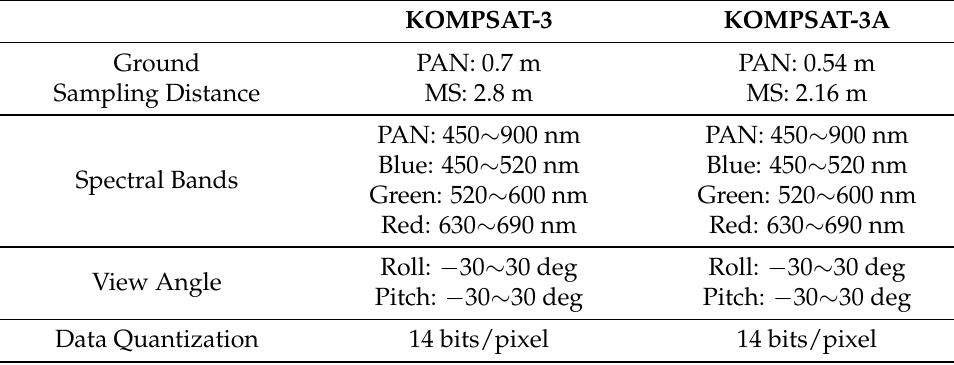
Table 1. Data Specification of Korea Multi-Purpose